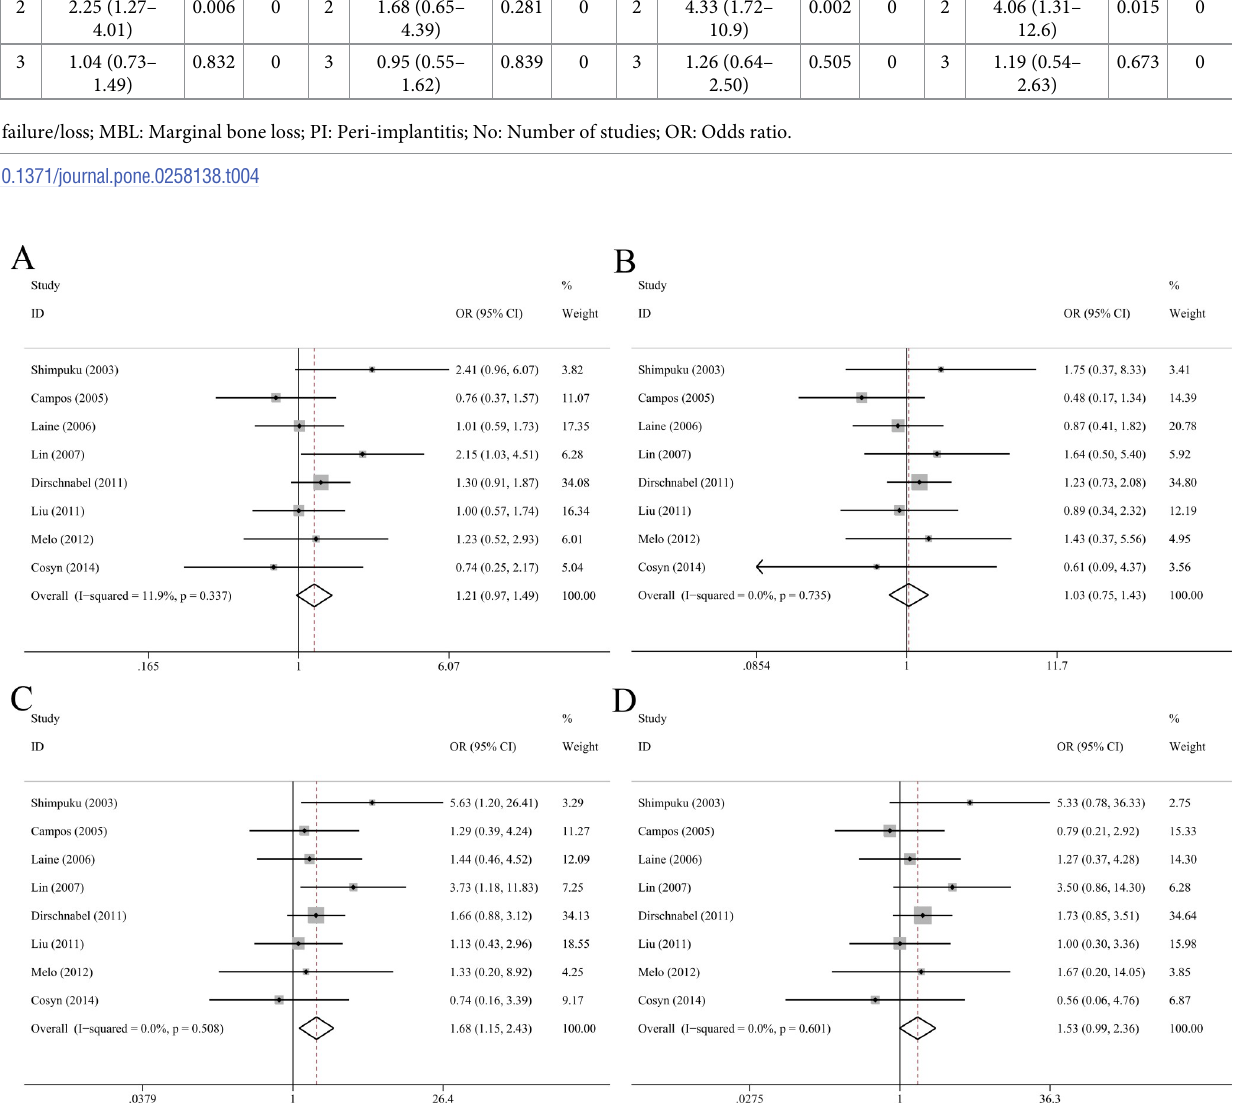
PLOS ONE | https://doi.org/10.1371/journal.pone.0258138 October 5,